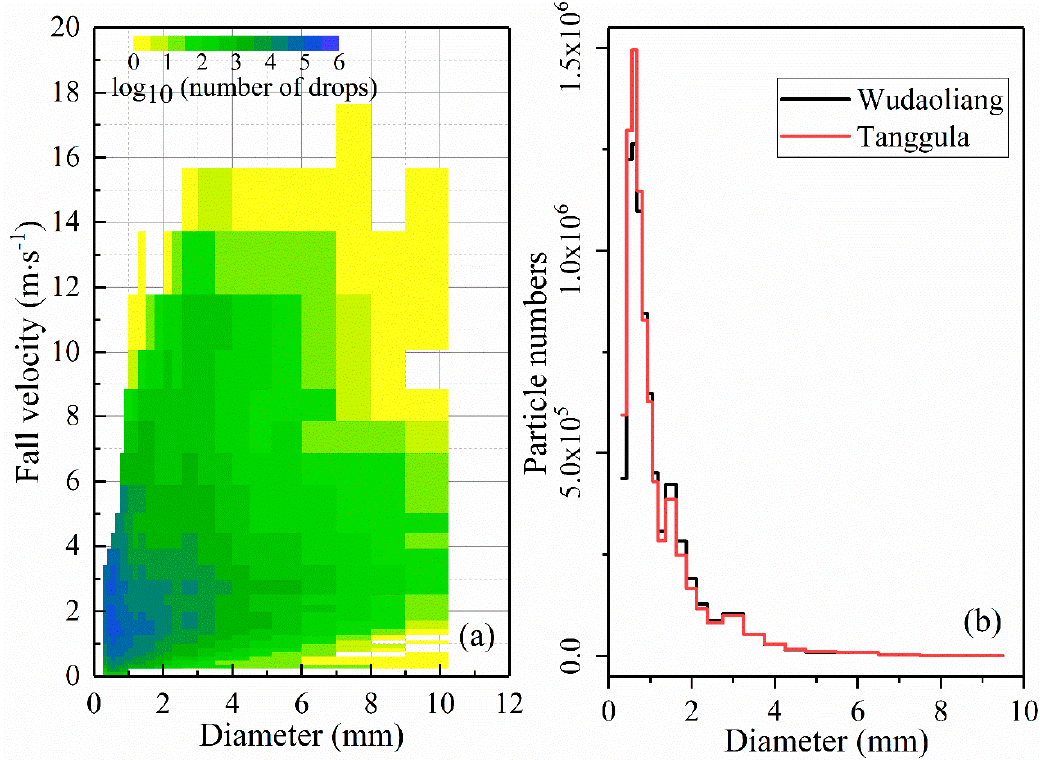
Figure 7. ( a ) The raindrop size distribution for Tanggula in 2015. ( b ) Changes in the size and amount of precipitation particles.